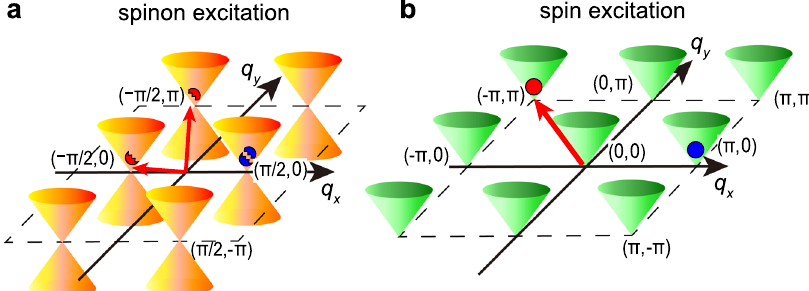
Fig. 5 Schematic illustration of the gapless excitation. a Gapless structure of the spinon in Brillouin zone inferred from the structure of the variational wavefunction discussed in Methods. b Experimentally measurable triplet excitation constructed from two-spinon excitations. Two examples of gapless excitations are shown: Two red spinons, one at ( − π /2, π ) and the other at ( − π /2, 0) in ( a ) can make measurable gapless triplet excitation shown in ( b ) at ( − π , π ). Two blue spinons at ( π /2, 0) in ( a ) can make measurable gapless triplet excitation shown in ( b ) at ( π ,